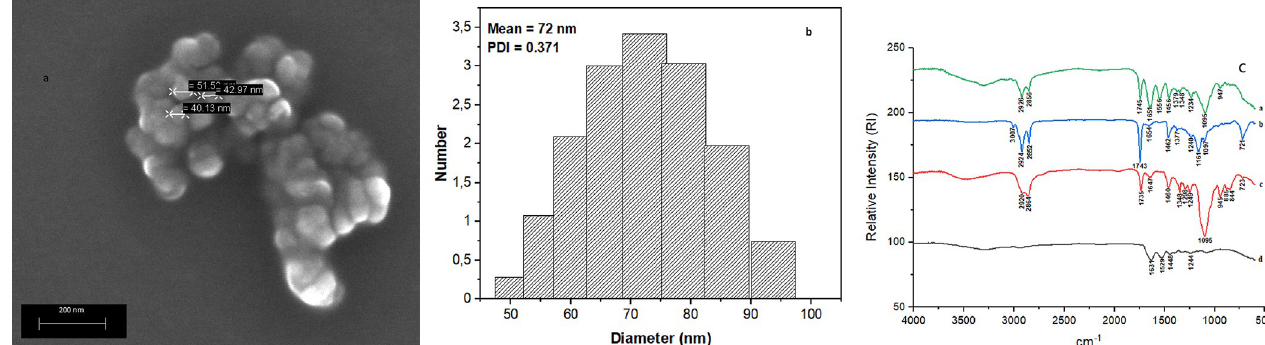
Fig 1. Characterization of buriti oil nanoencapsulated in porcine gelatin. A. Micrograph obtained by Scanning Electron Microscopy. B. Dynamic light scattering. C. Fourier Transform Infrared Spectroscopy of nanoencapsulated buriti oil (a), buriti oil (b), Tween 20 (c), porcine gelatin (d).